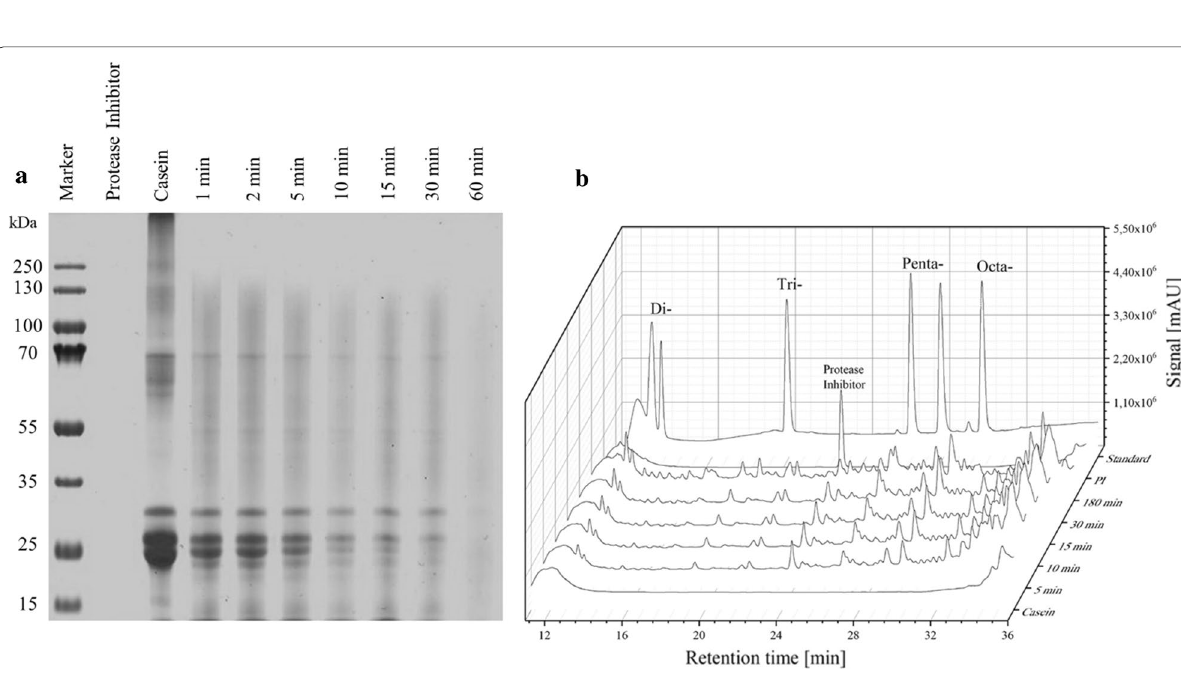
Fig. 3 Casein digestion with Alcalase over time. a Non-reduced SDS-PAGE 12% Tris gel stained with Coomassie Brilliant Blue R-250, molecular mass standard Prestained Protein Marker (250 kDa), b HPLC analysis performed on reversed phase C18 column, using HPLC peptide standard